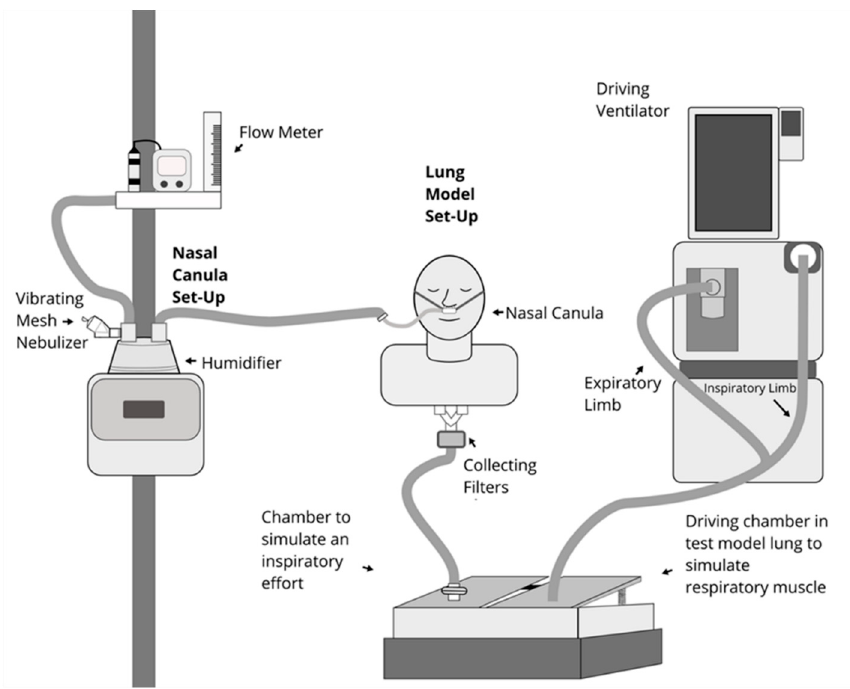
Figure 1. Experiment set up.